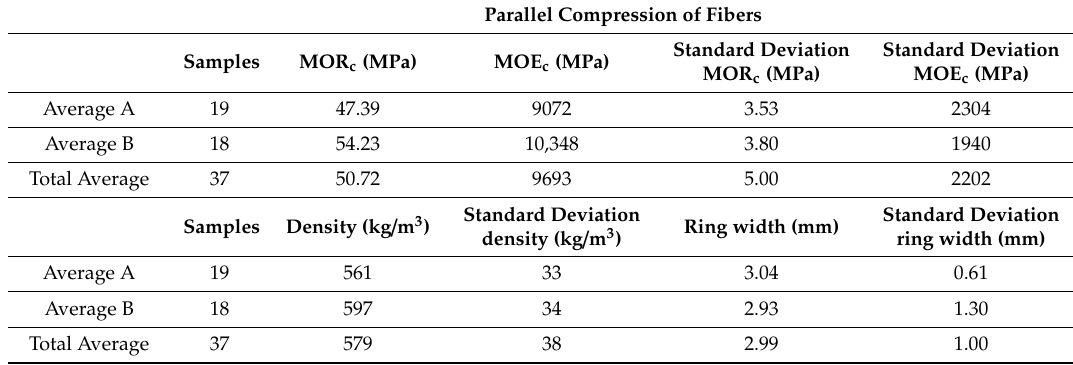
Table 3. Average value of compressive strength (MOR c ) and MOE c , density, and ring